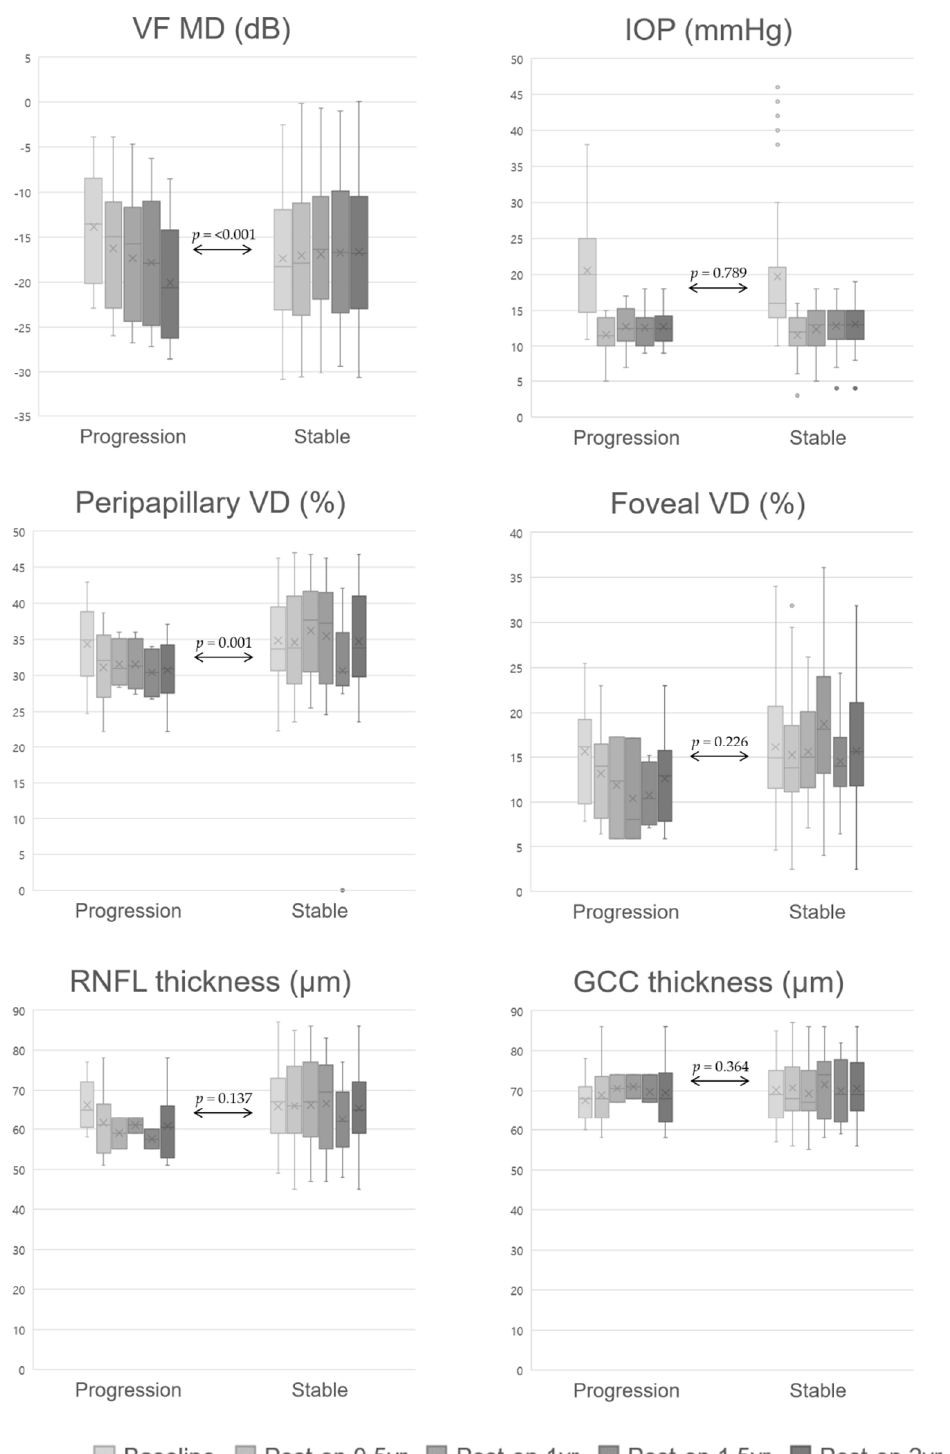
Figure 1. Comparison of postoperative parameter changes between the VF progression and non-progression group. Repeated measures ANOVA was used to compare the post-operative changes of each parameter, and the p -values of repeated measures ANOVA were presented. X: average value, horizontal line: median value, dots: outliers. Abbreviations: GCC, ganglion cell complex; IOP, intraocular pressure; RNFL, retinal nerve fiber layer; VD, vessel density; VF MD, visual field mean deviation.